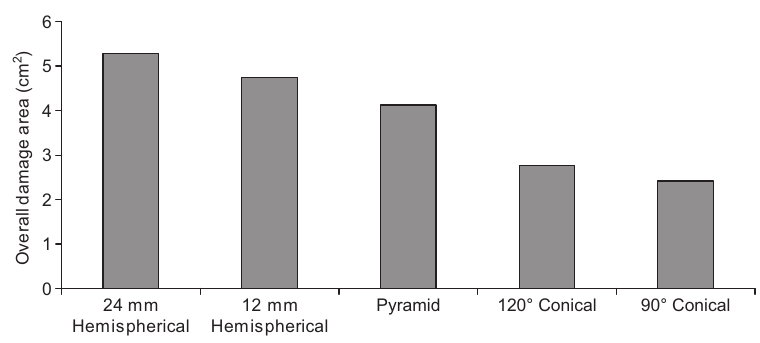
The 24 mm hemispherical impactor produced the lowest 2. defl ection whereas the 90 ° conical impactor produced the highest defl ection; In all specimens back surface damages were greater than 3. those that occurred in the front; Greater damage area was observed in tests carried out with 4. the 24 mm hemispherical tap since bending deformation occurred and the damage zone extended to the edges of the specimen. The smallest damage area was observed in the sample impacted with the 90 ° conical tap; Absorbed energy is the greatest for the pyramidal shaped 5. impactor whereas it is the smallest for the 24 mm spherical impactor